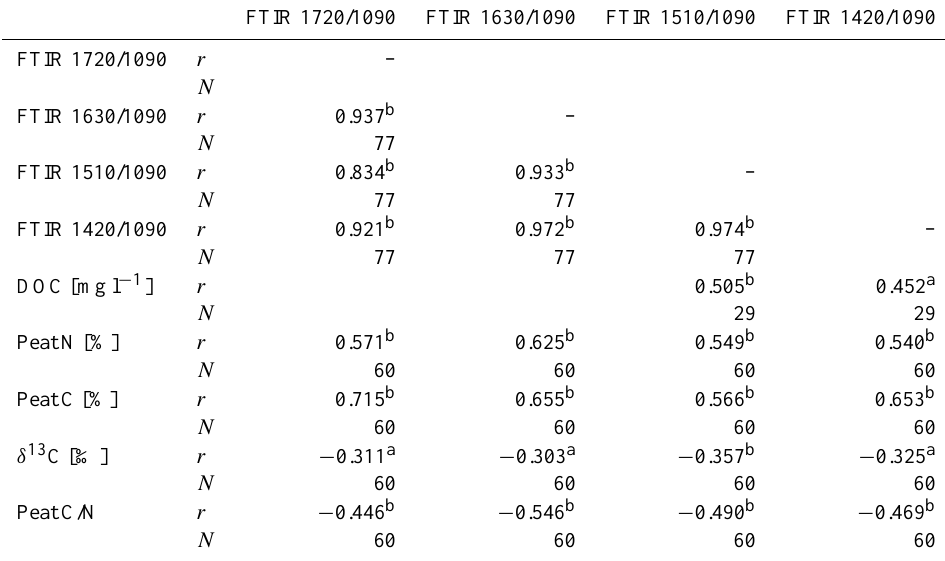
Table 3. Correlation coefficients after Pearson ( r ), with N as number of sample. Asterisks indicate different levels of significance. Only significant correlations are shown.